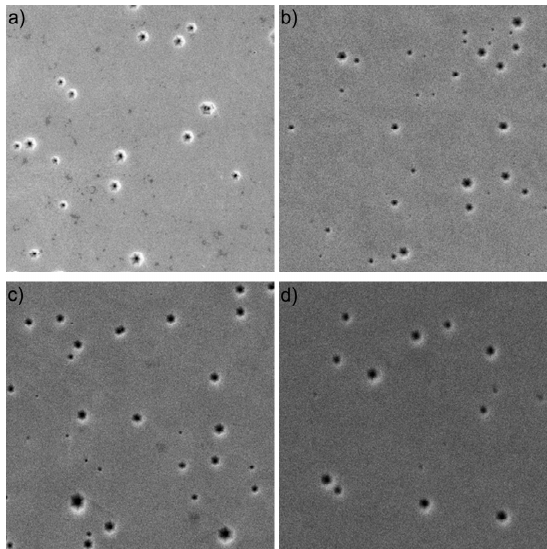
Fig. 3. SEM images of samples (a) A, (b) B, (c) C and (d) D. Frames of all images are 10x10  m 2 .